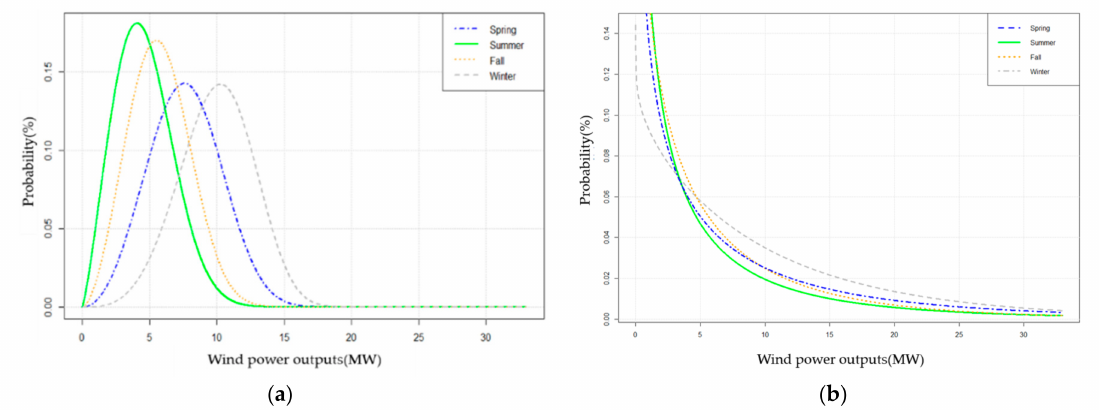
Figure 2. Seasonal Weibull distributions based on two parameter estimation methods: ( a ) Seasonal Weibull distributions of wind farm A based on moment method; ( b ) seasonal Weibull distributions of wind farm A based on maximum likelihood method.